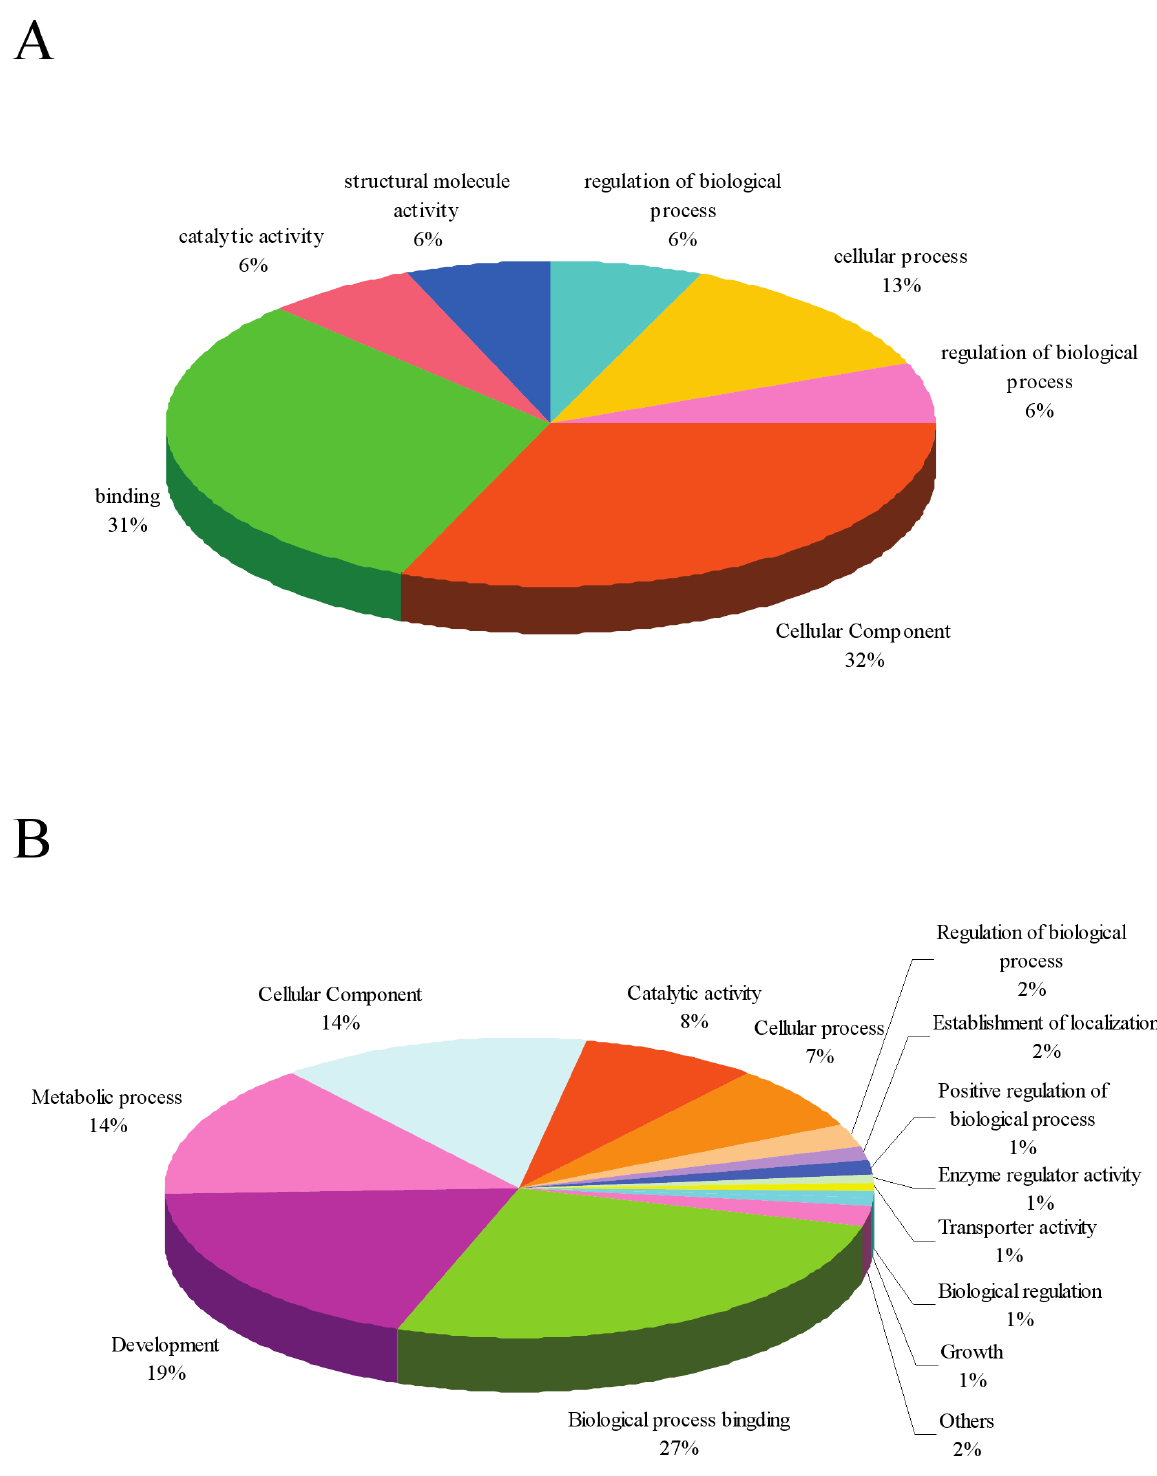
Figure 4. Pie chart showing the distribution of GOs for expressed genes in schistosomula from Microtusfortis A represents the category of the GOs for genes up regulated in worms from Microtusfortis . B represents the category of the GOs for genes down regulated in worms from Microtus fortis . doi:10.1371/journal.pone.0021109.g004 qPCR validation Nine genes with different biological functions were selected for qPCR to validate the microarray transcription results. The primer